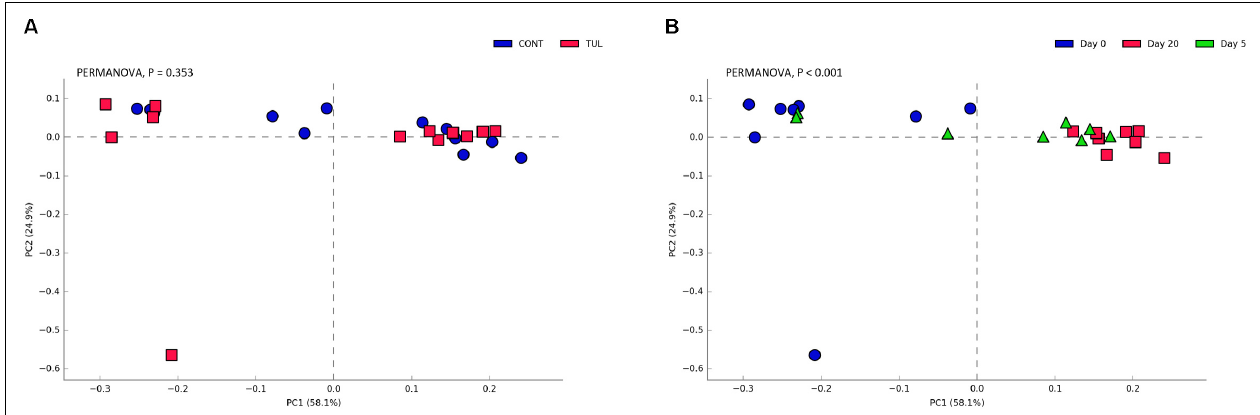
FIGURE 8 | (A) Principal component analysis (PCA) based on non-phylogenetic Bray–Curtis distance metrics for the overall fecal antimicrobial resistance genes between the control (CONT) and tulathromycin (TUL) piglets. (B) Principal component analysis (PCA) for the overall fecal antimicrobial resistance genes across all samples at different sampling days (0, 5, and 20). The percent variation explained by each component is indicated on the axes. Significance between the two groups was analyzed using PERMANOVA with 9999 permutations and Bonferroni corrected P-